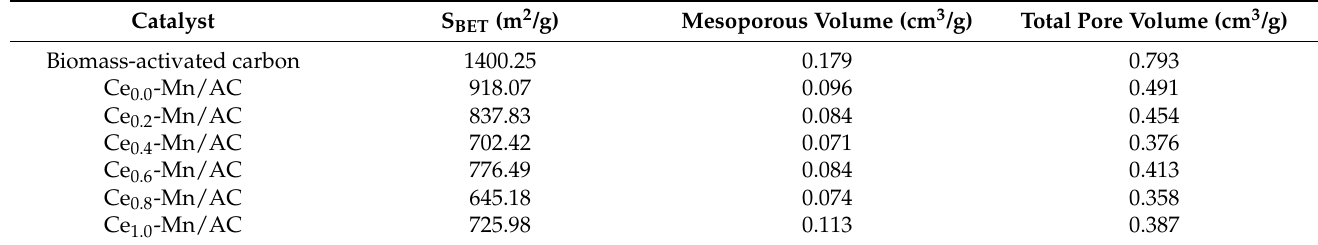
Table 1. Porous structural parameters of samples.